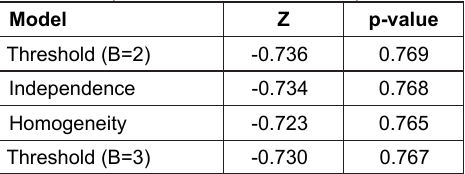
Table 45. Field data for the 2015 Tuktoyaktuk Peninsula Herd post calving survey.